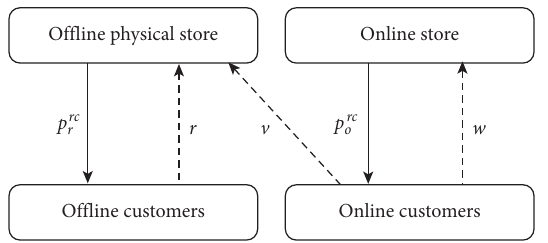
Figure 3: Relaxed cross-channel return